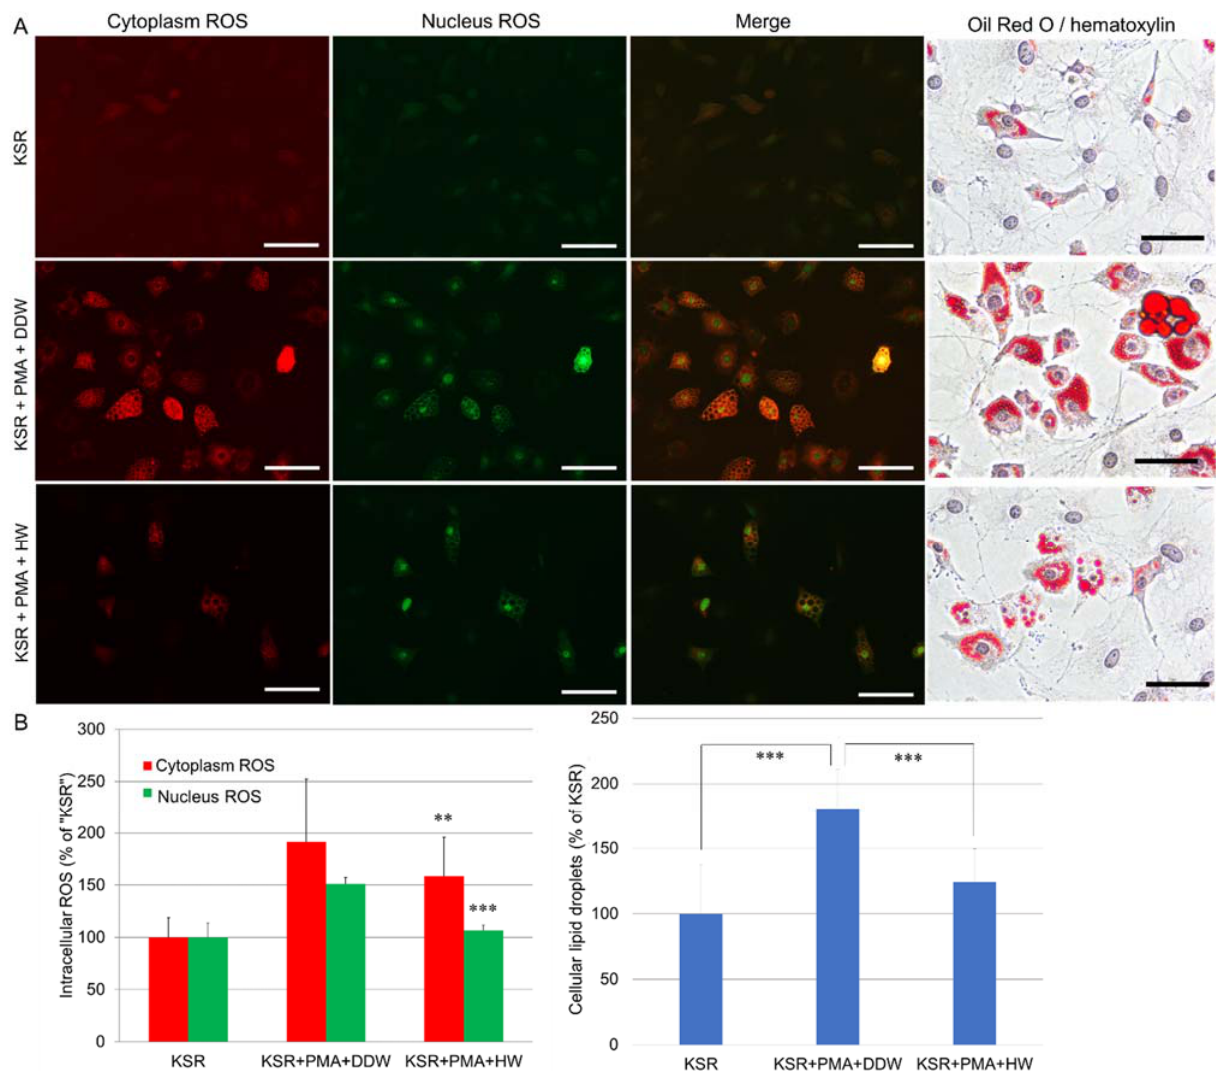
Figure 6. Repressive effects of HW on phorbol 12-myristate 13-acetate (PMA)-induced intracellular ROS and lipid accumulation in OP9 adipocytes. ( A ) OP9 preadipocytes (30,000 cells/well) were seeded into 24-well plates and grew up to 100% confluence in the maintenance medium. Cells were then cultivated in DDW- or HW-prepared KSR medium with or without PMA of 10 ng/mL for 4 days. The NC cells were cultivated in the maintenance medium. At the end of cultivation, cellular ROS were detected with CellROX ® green and orange dyes and observed with a fluorescence microscope. To quantitatively analyze the cellular ROS, green and red fluorescence in OP9 cells were measured with the Tali image-based cytometer. For Oil Red O staining, OP9 cells were prepared similar to what we described in Figure 4. ( A ) Left panel:typical images of CellROX ® green and orange staining. Green, nucleus ROS; red, cytoplasm ROS. Scale bar = 25 µm. Right panel: typical images of Oil Red O staining. Scale bar = 25 µm. ( B ) Left panel: OP9 cells were detached from the culture substratum-surface by trypsin and followed by Tali-cytometric analysis as described in materials and methods. ** p < 0.01; *** p < 0.01 vs. KSR+PMA+DDW. Right panel: after Oil Red O staining, the intracellular dye was extracted and transferred to a 96-well plate and quantified in a microplate reader at 520 nm. *** p < 0.001 vs. KSR+PMA+DDW. Data are expressed as percentage of the negative control, and each concentration point and bar represent the mean ± SD of five independent experiments.